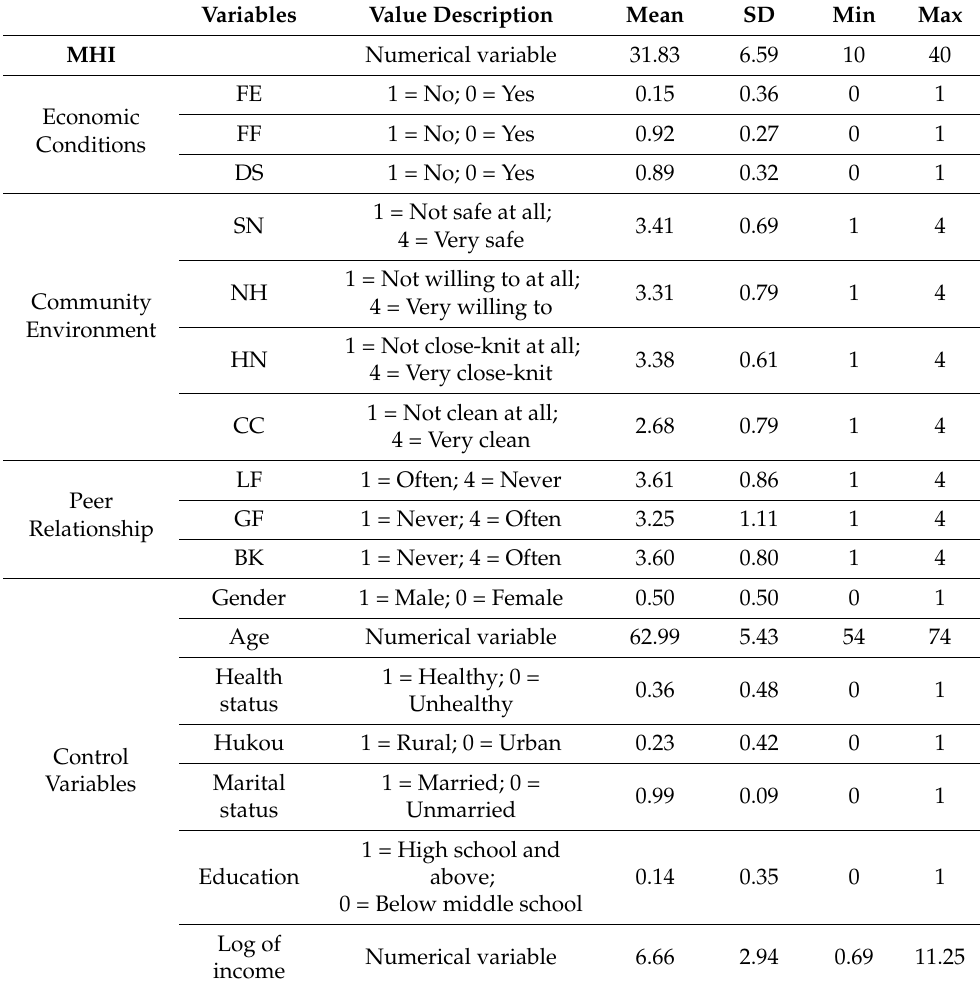
Table 1. Descriptive statistics (N =